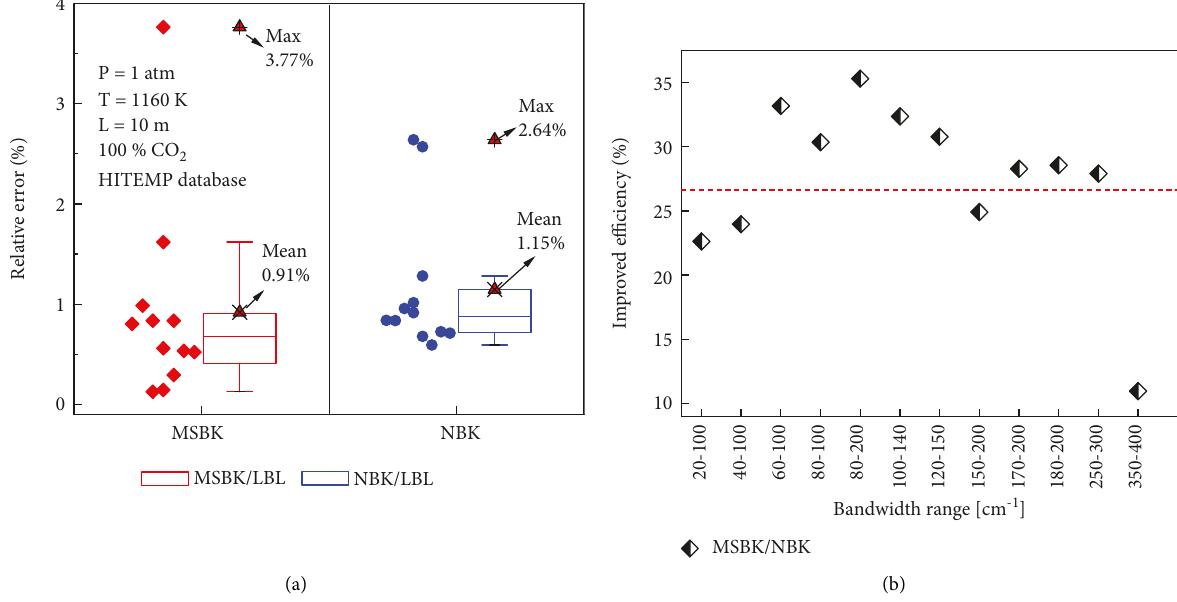
Figure 8: Accuracy and efficiency of the MSBK model at different bandwidth ranges.